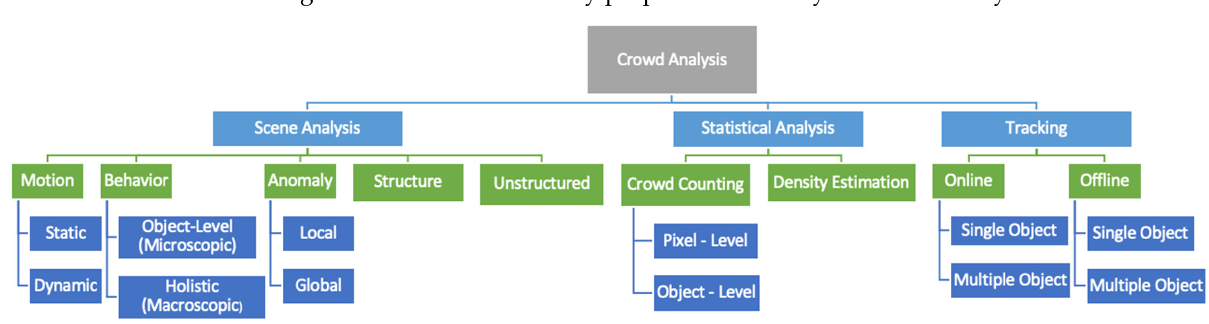
Figure 2. Proposed taxonomy for crowd analysis.